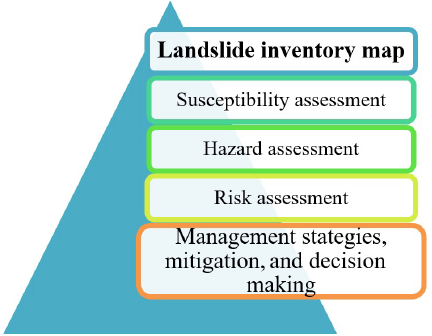
Figure 1. Landslide inventory maps are the origin for landslide haz- ard and risk (Dai et al., 2002; Fell et al.,